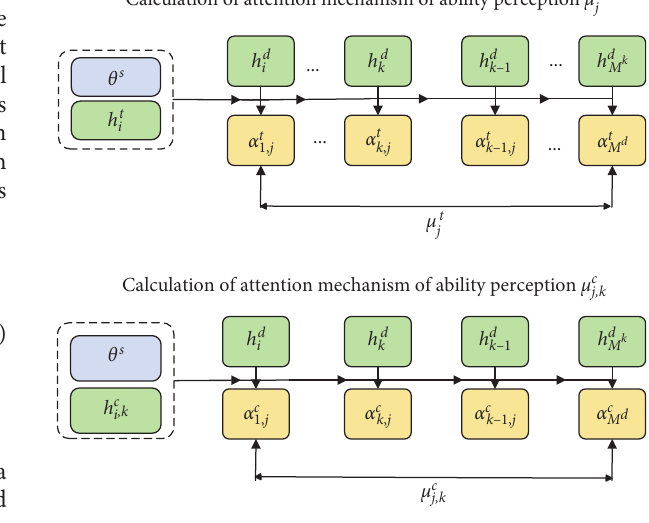
Figure 3: Schematic diagrams of the attention mechanism under ability perception: (a) calculation of attention mechanism of ability perception μ t j and (b) calculation of attention mechanism of ability perception μ c j,k